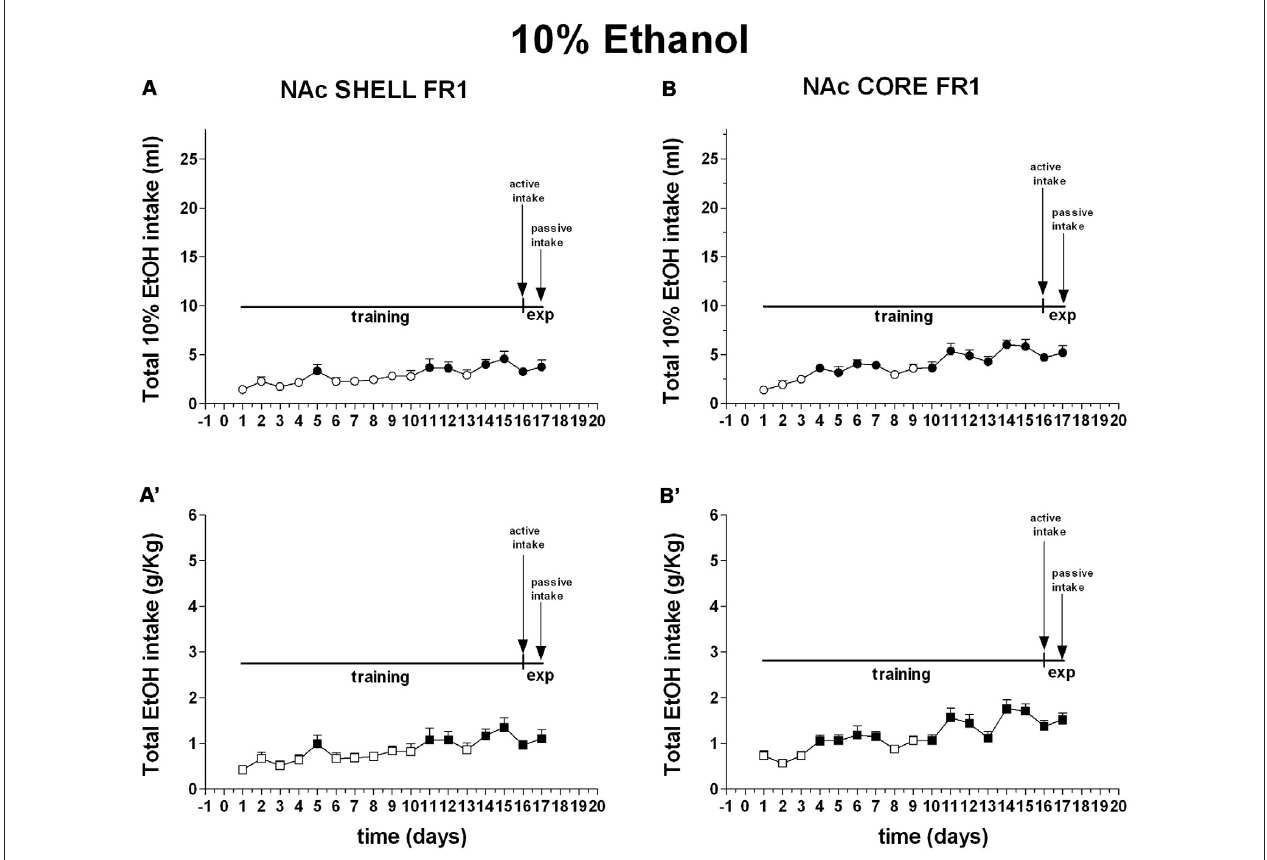
FIGURE 9 | Total intake expressed as ml of 10% ethanol solution and g/Kg of ethanol. Data are means ± SEM of the results obtained in rats implanted with guide cannulas in the NAc shell ( A :ml; A (cid:48) :g/Kg; N = 7) and rats in the NAc core ( B :ml; B (cid:48) :g/Kg; N = 7). Filled symbols, p < 0.05 vs. 1st